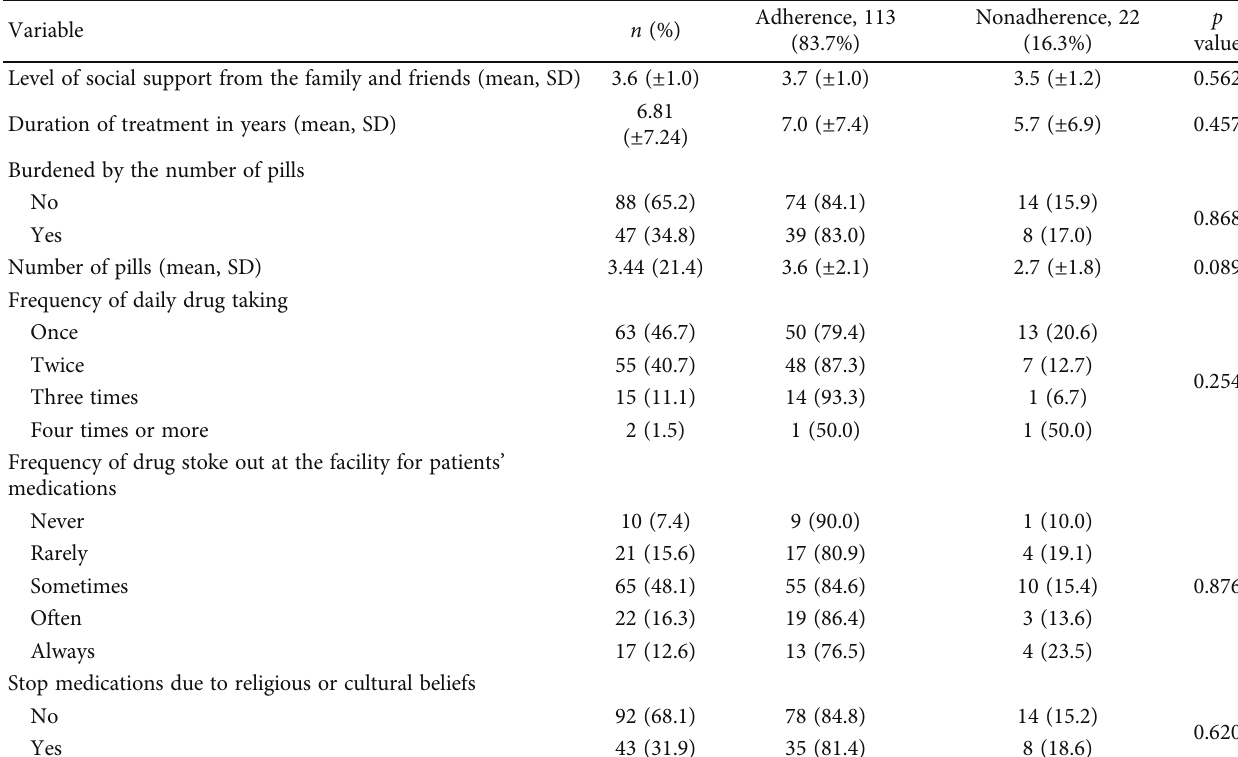
Table 3: Treatment-related factors for patients with schizophrenia on typical